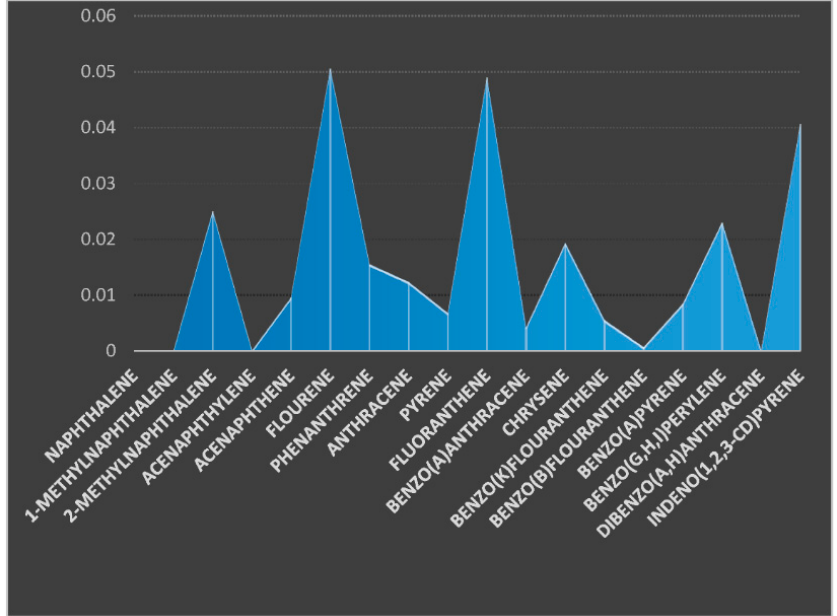
Figure 3. Concentration of PAHs components ( µ g/kg) in the soil sample from location 2.